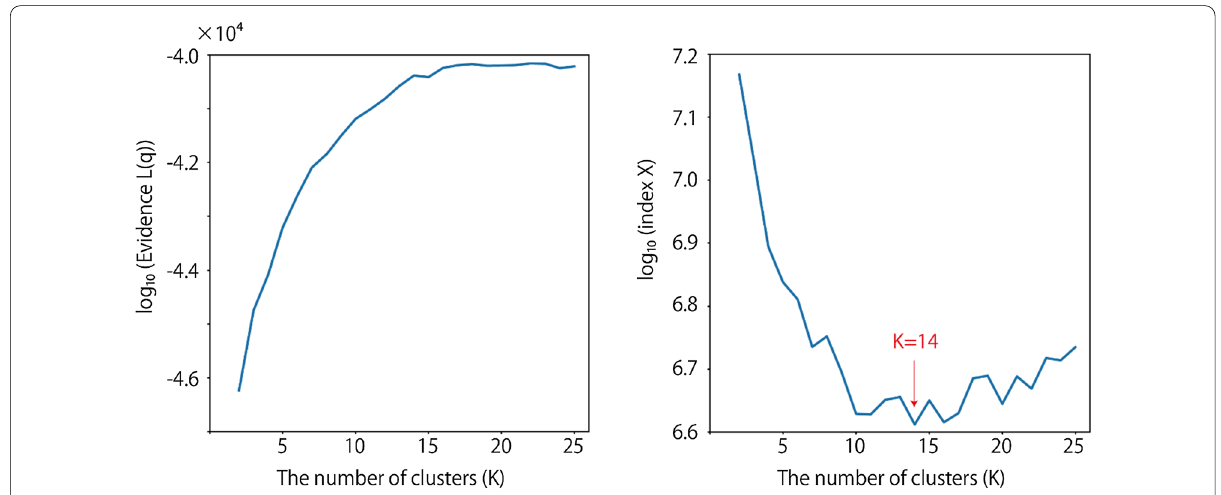
Fig. 6 Grid search results of Evidence L ( q ) and index X for the number of clusters ( K ) at Site